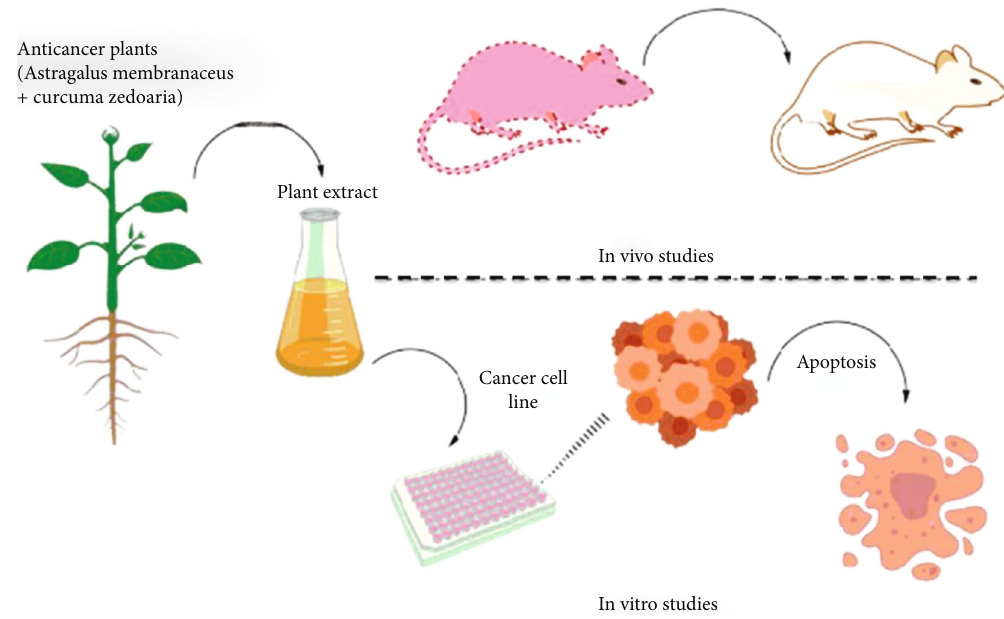
Figure 2: Anticancer activity of medicinal plant Table 1: List of available herbal medicines.